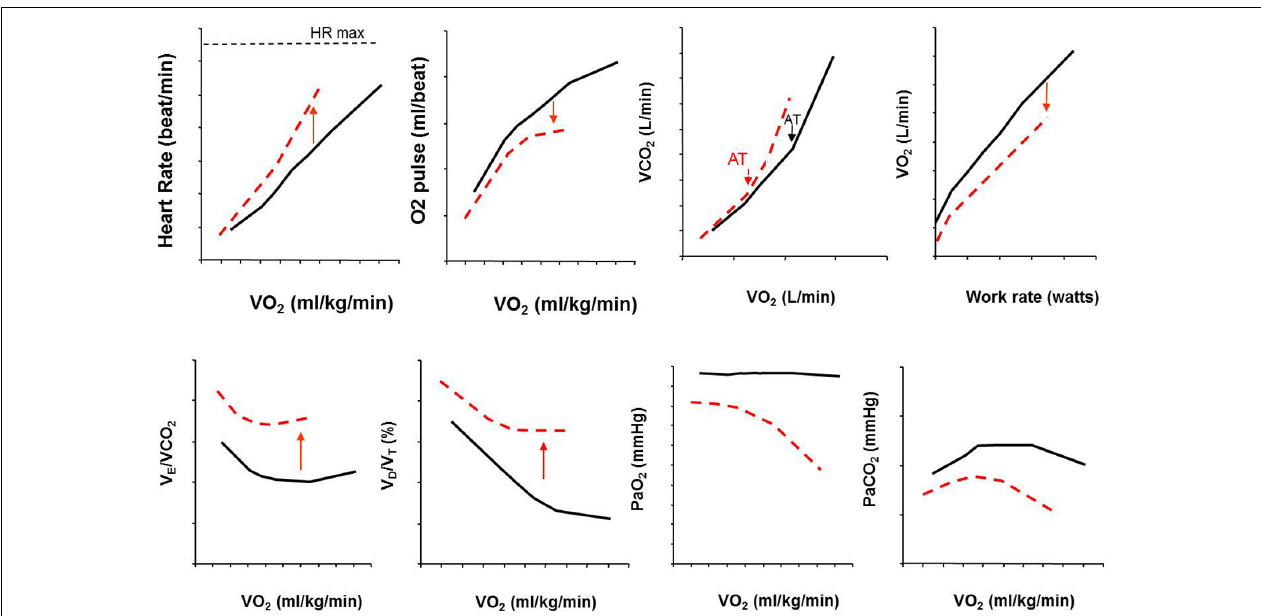
FIGURE 3 | Typical exercise response profile of a PAH patient (red dotted line) compared with healthy control (black line) undergoing maximal incremental symptom-limited CPET. Abbreviations in the text. This is an original figure, no permission is required.